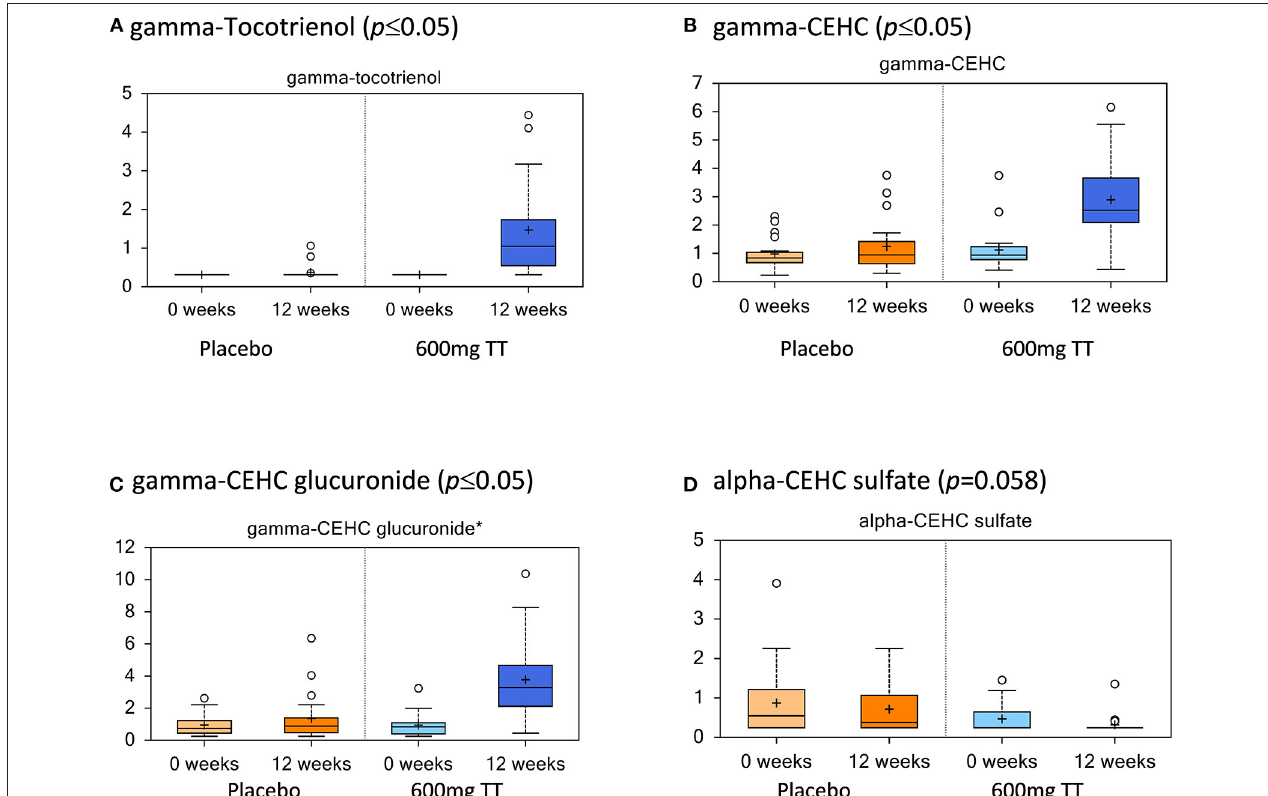
FIGURE 2 | Tocotrienols and their metabolites in serum of the placebo and the 600mg TT groups at 0 and 12 wk. Values represent fold differences in serum tocotrienol and metabolites in placebo and 600mg TT treatment from serum analysis of subjects. Tocotrienols increased with supplementation and were higher compared to the placebo group (A–D)